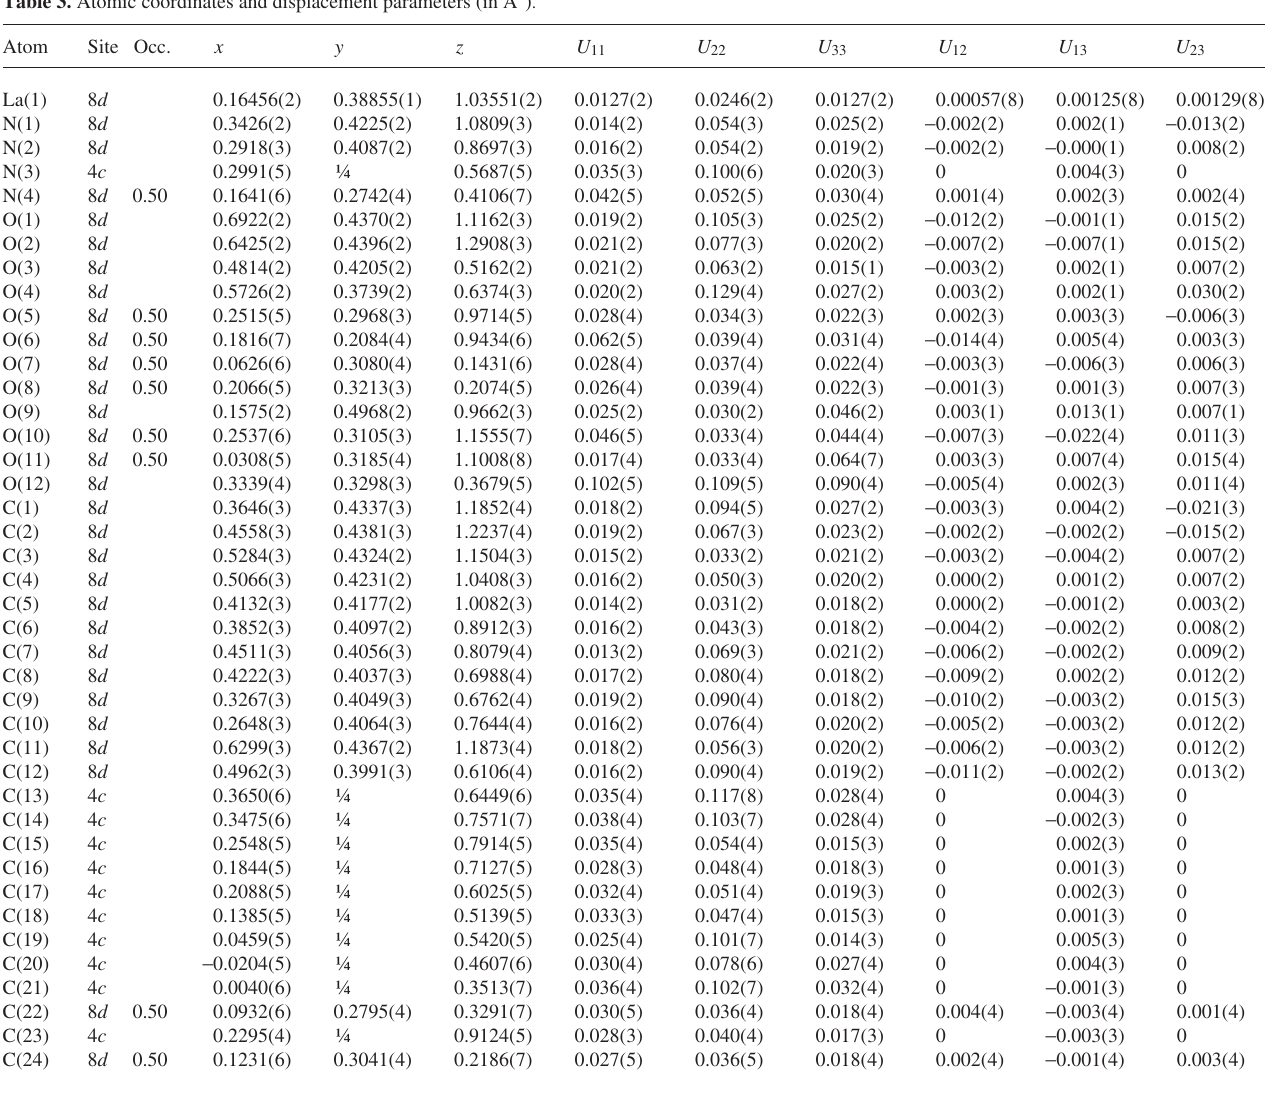
Table 3. Atomic coordinates and displacement parameters (in Å 2 )